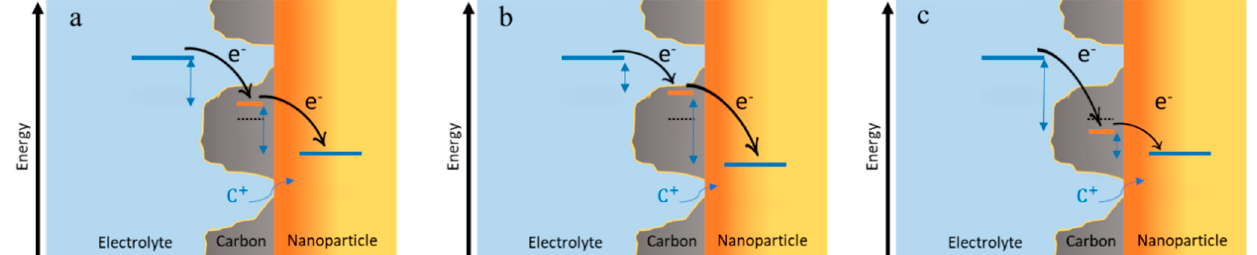
Figure 8. Fermi level equilibration of the carbon between redox electrolyte red 1 /ox 1 and redox solid red 2 /ox 2 nanoparticle. The position of the Fermi level of the carbon depends on the rates of the half-reactions taking place at its two ends and locates: ( a ) right in the middle of Fermi levels of the redox electrolyte and the redox solid when the product of exchange current densities and surface areas of both half-reactions are equal ( 𝐴 (cid:2925)(cid:2934) 𝑖 (cid:2868),(cid:2925)(cid:2934) = 𝐴 (cid:2928)(cid:2915)(cid:2914) 𝑖 (cid:2868),(cid:2928)(cid:2915)(cid:2914) ); ( b ) closer to the Fermi level of the oxidation half-reaction when 𝐴 (cid:2925)(cid:2934) 𝑖 (cid:2868),(cid:2925)(cid:2934) ≫ 𝐴 (cid:2928)(cid:2915)(cid:2914) 𝑖 (cid:2868),(cid:2928)(cid:2915)(cid:2914) ; ( c ) closer to the Fermi level of the reduction half-reaction when 𝐴 (cid:2925)(cid:2934) 𝑖 (cid:2868),(cid:2925)(cid:2934) ≪ 𝐴 (cid:2928)(cid:2915)(cid:2914) 𝑖 (cid:2868),(cid:2928)(cid:2915)(cid:2914) (orange indicates the intercalated zone in nanoparticle, and yellow indicates the pristine nanoparticle).